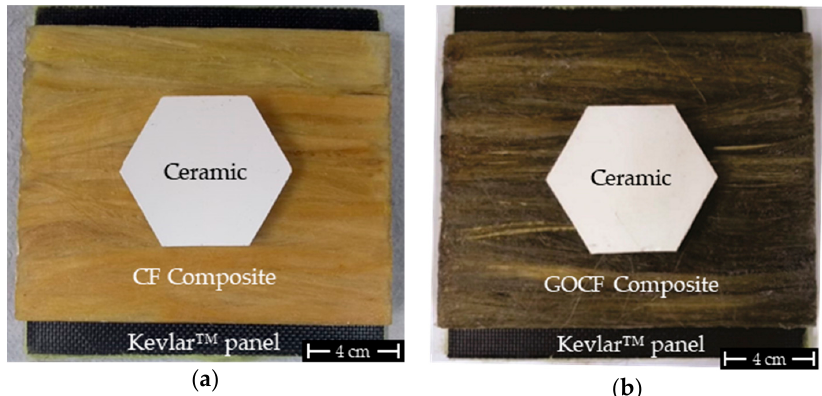
Figure 2. Multilayer armor system (MAS) mounted: ( a ) MAS with CF composite and ( b ) MAS with GOCF composite.